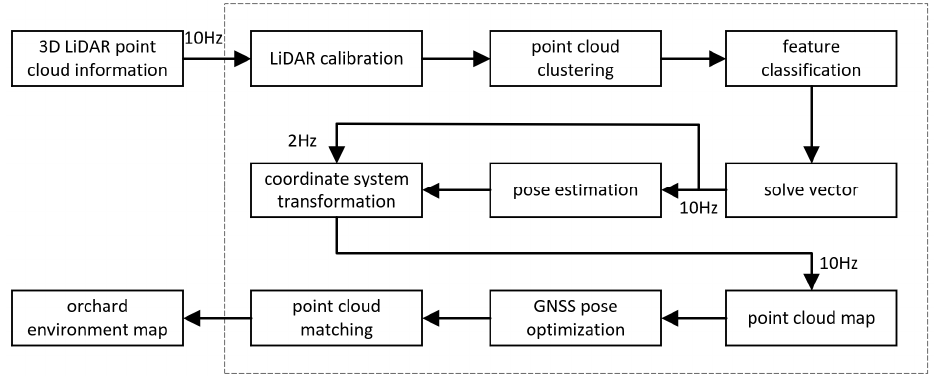
Figure 3. Construction process of orchard point cloud map.